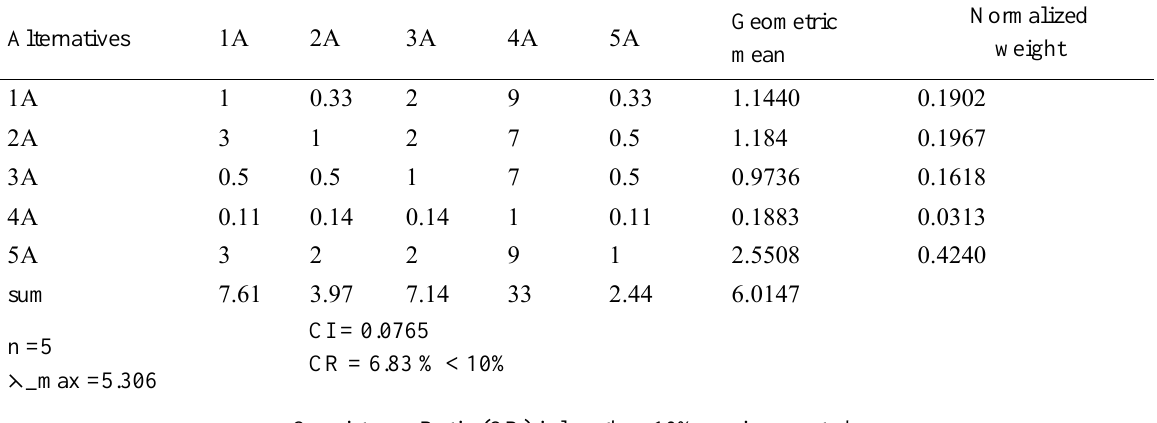
Table 8. Comparison Matrix of Alternatives with respect to C4.